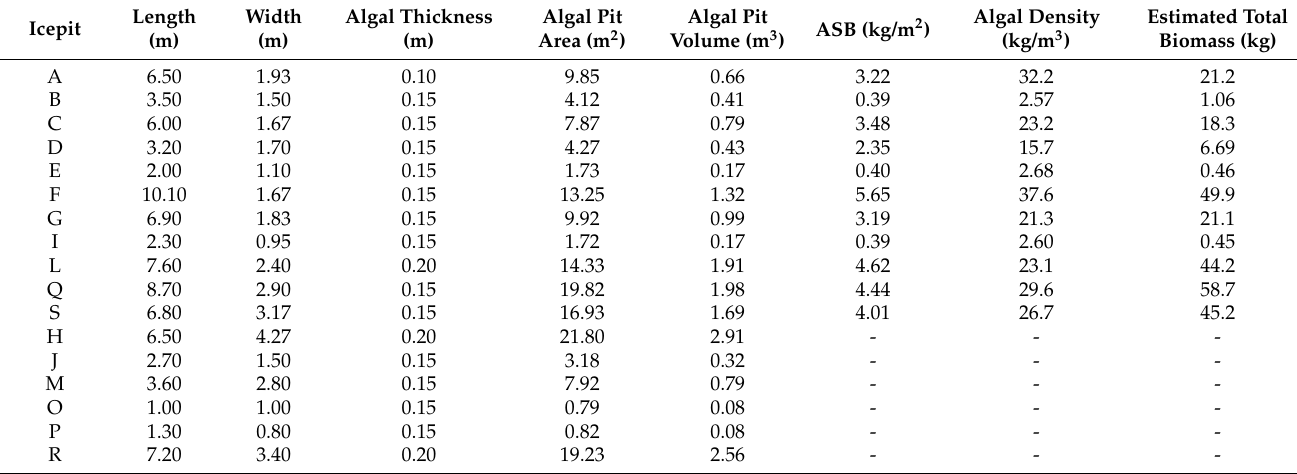
Table 1. Geographical positions, dimensions, and algal biomass of ice pits. Six ice pits were not sampled for algal composition. For large ice pits, multiple length and width dimensions were measured, and the average values are shown here. Algal thickness was measured in the center of each ice pit; pit volume was calculated using a hemi-ellipsoid formula; and the Area-Specific Biomass (ASB) was based on the mean of two 0.25-m 2 quadrats in each ice